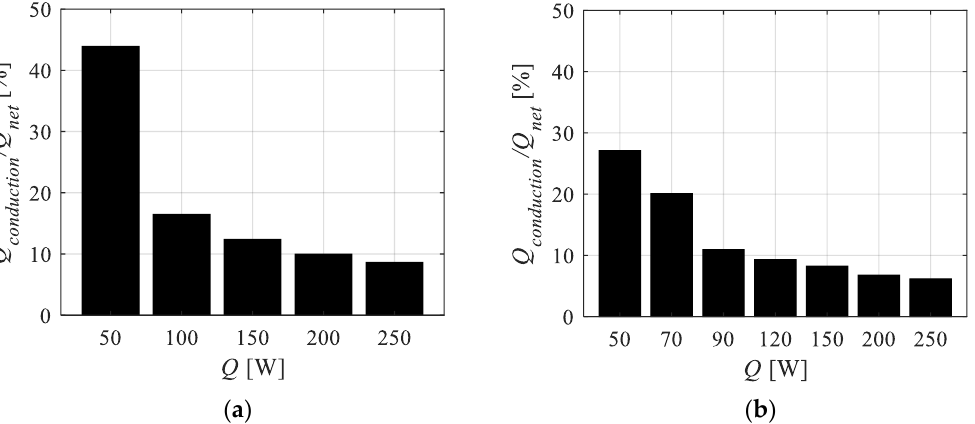
Figure 15. Ratio between the power transferred by conduction between the evaporator and the condenser and the net power input to the evaporator as a function of power input for the horizontal orientation ( a ) and the vertical BHM ( b ).